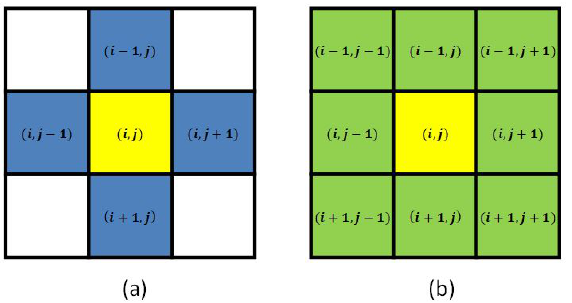
Figure 2. Neighborhoods. ( a ) A Von Neumann-neighborhood with a radius of 1. ( b ) A Moore- neighborhood with a radius of